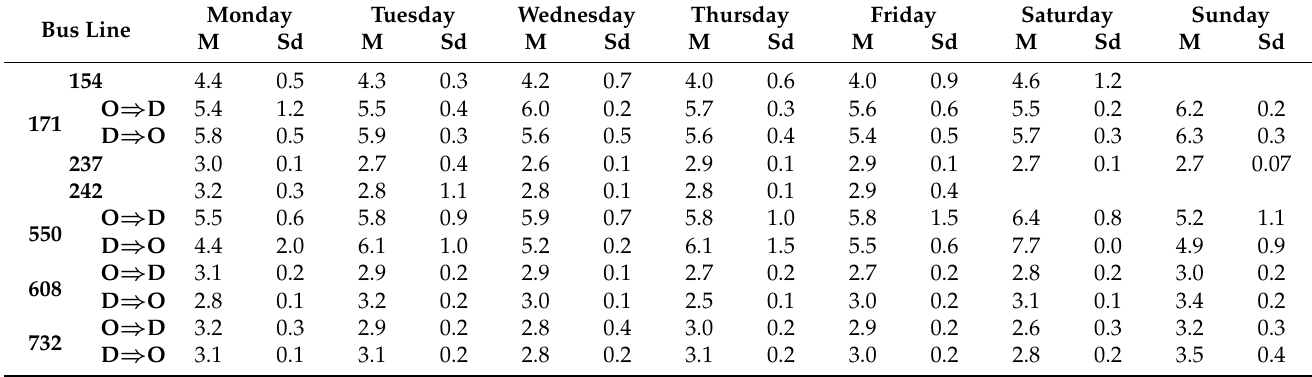
Table 4. Travel distance (km) per passenger per day and bus